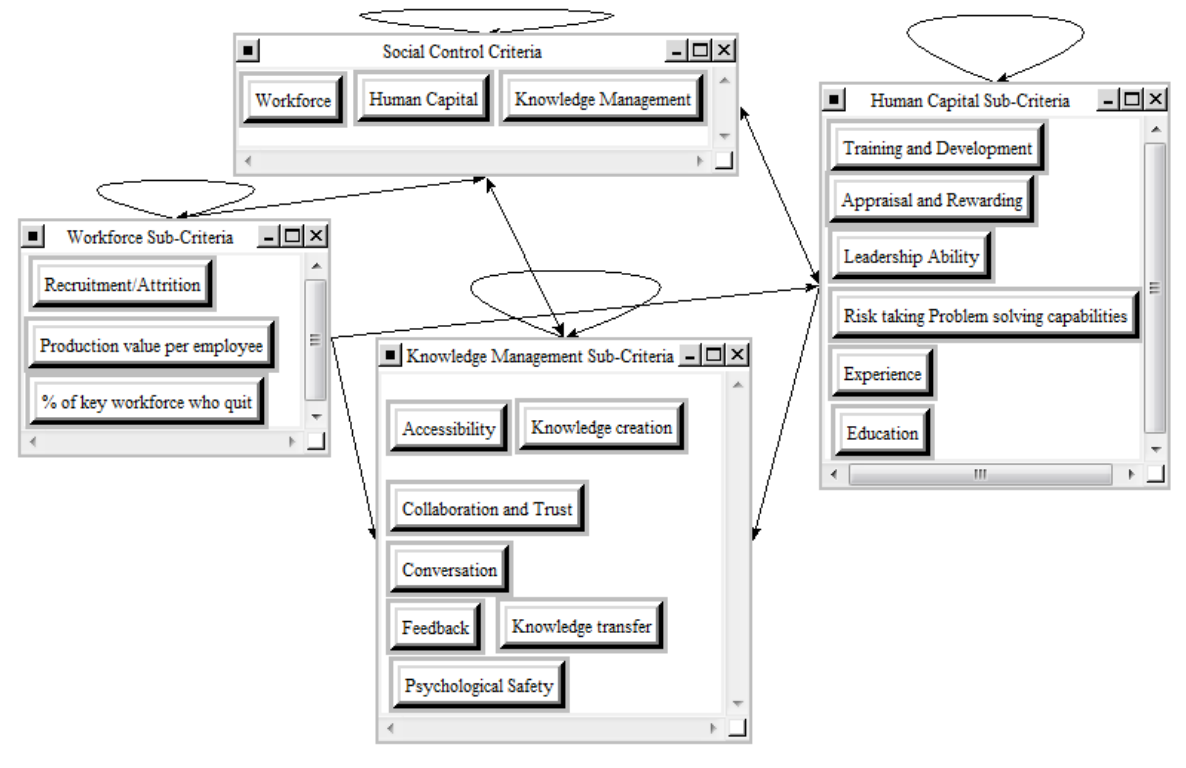
Figure 3. Social Sector of the ANP